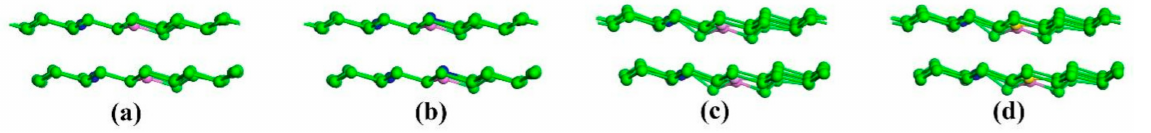
Figure 10. The side views for atomic multilayered structures of proposed germanene-based models including single-vacancy germanene co-doped with the ( a ) NAl, ( b ) NNAl, ( c ) NPAl and ( d )